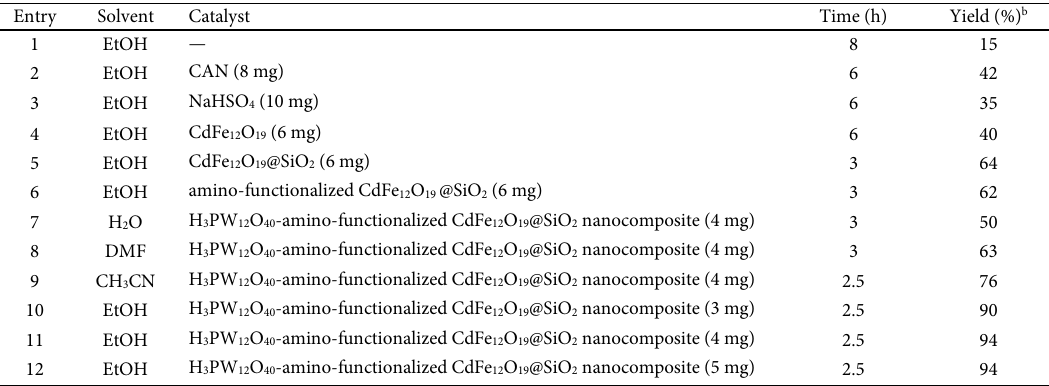
Table 2. Synthesis of thiazole-2(3H)-thiones using H 3 PW 12 O 40 -amino-functionalized CdFe 12 O 19 @SiO 2 nanocomposite (4 mg)